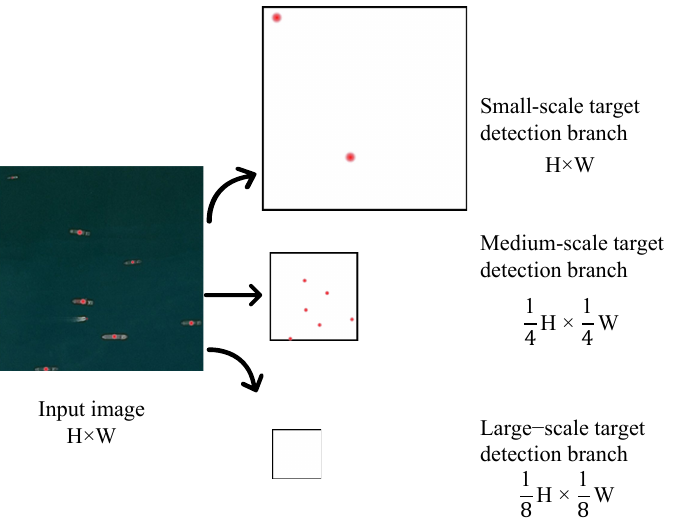
Figure 5. Heat map of the center point of each branch of the hierarchical scale sensitive